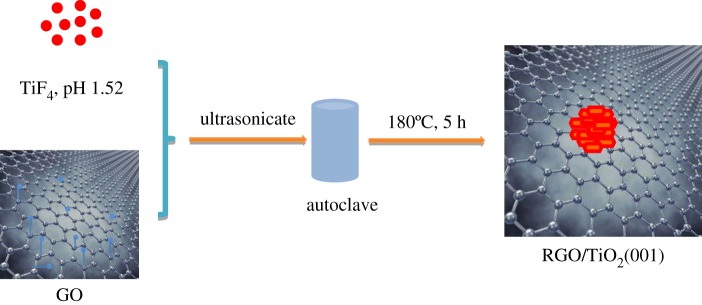
Illustration of preparation of RGO/{001} faceted TiO2.